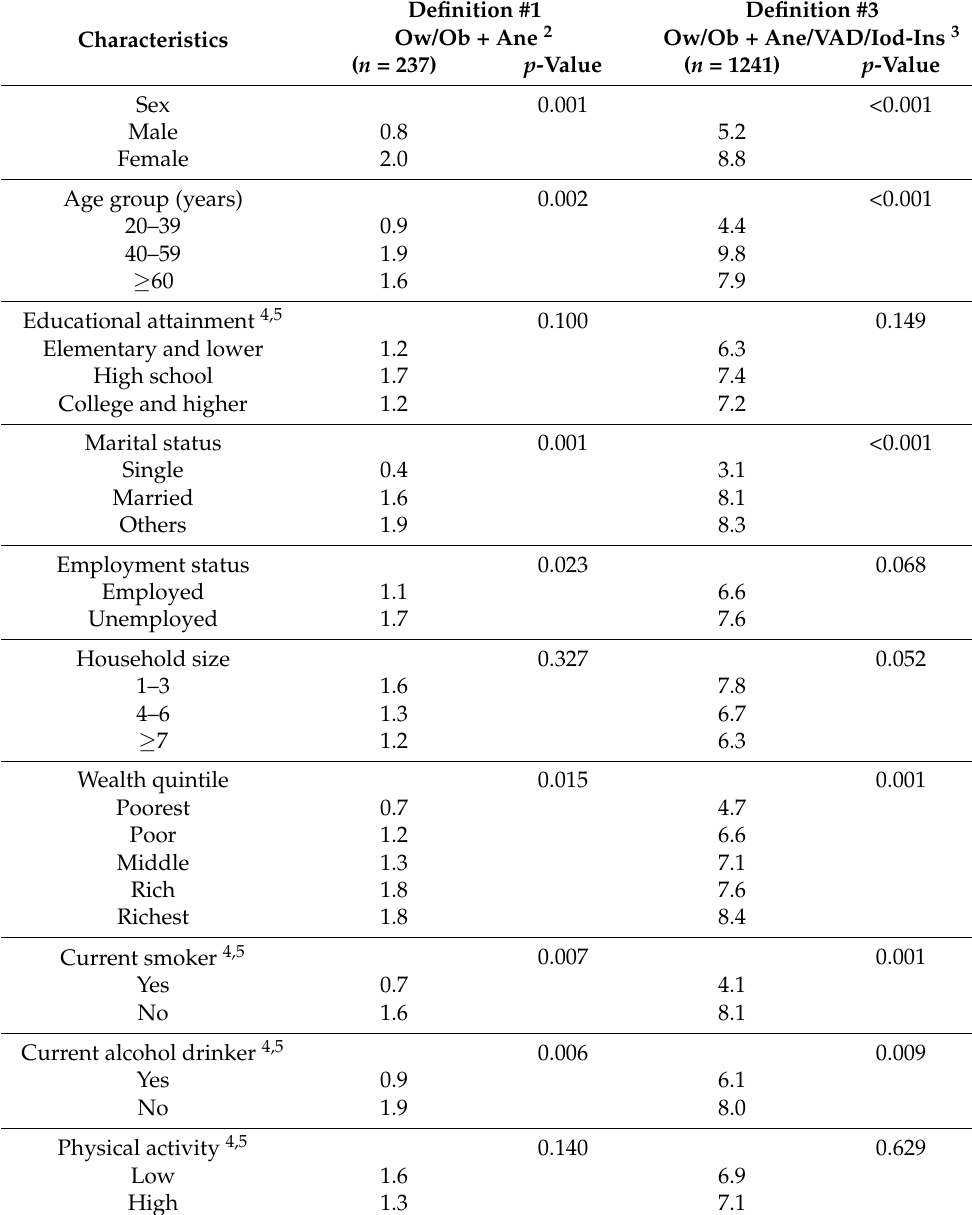
Table 3. Bivariate analysis for factors related to DBM in adults in the Philippines 1